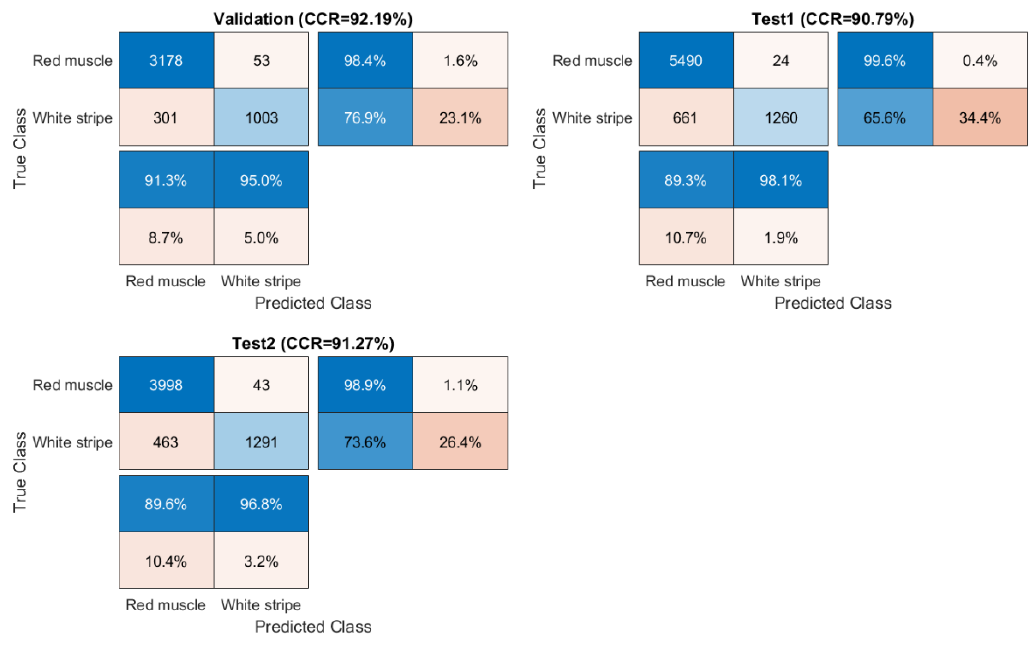
Figure 13. Confusion matrices for validation and test sets obtained by the 3 ‐ D CNN model built from EPO pre ‐ treated